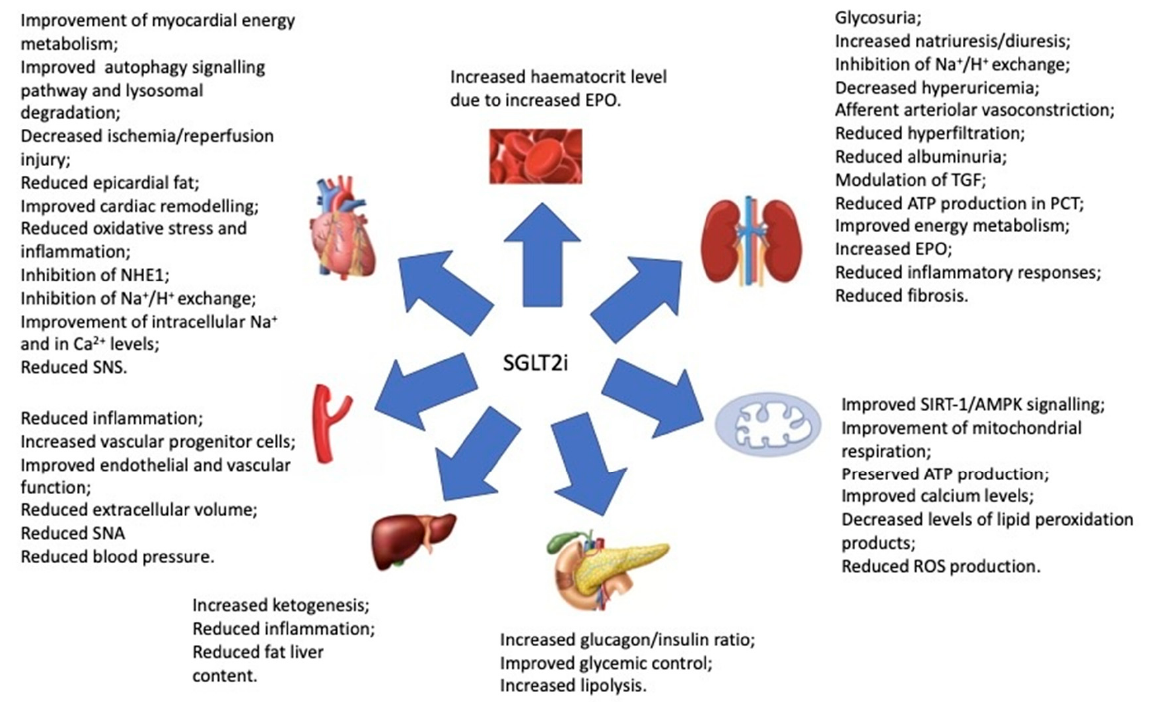
Figure 2. Systemic beneficial effects of SGLT2 inhibitors that contributes to cardiovascular and renal protection. AMPK, Adenosine Monophosphate Kinase; ATP, Adenosine Triphosphate; EPO, Erythrpoietin; NHE1, Sodium Hydrogen Exchange 1; PCT Proximal Convoluted Tubule; ROS, Reactive Oxygen Species; SGLT2i, Sodium Glucose Transporter 2 inhibitors; SIRT-1 Sirtuin 1; SNS, sympathetic nervous system; TGF, Tubuloglomerular